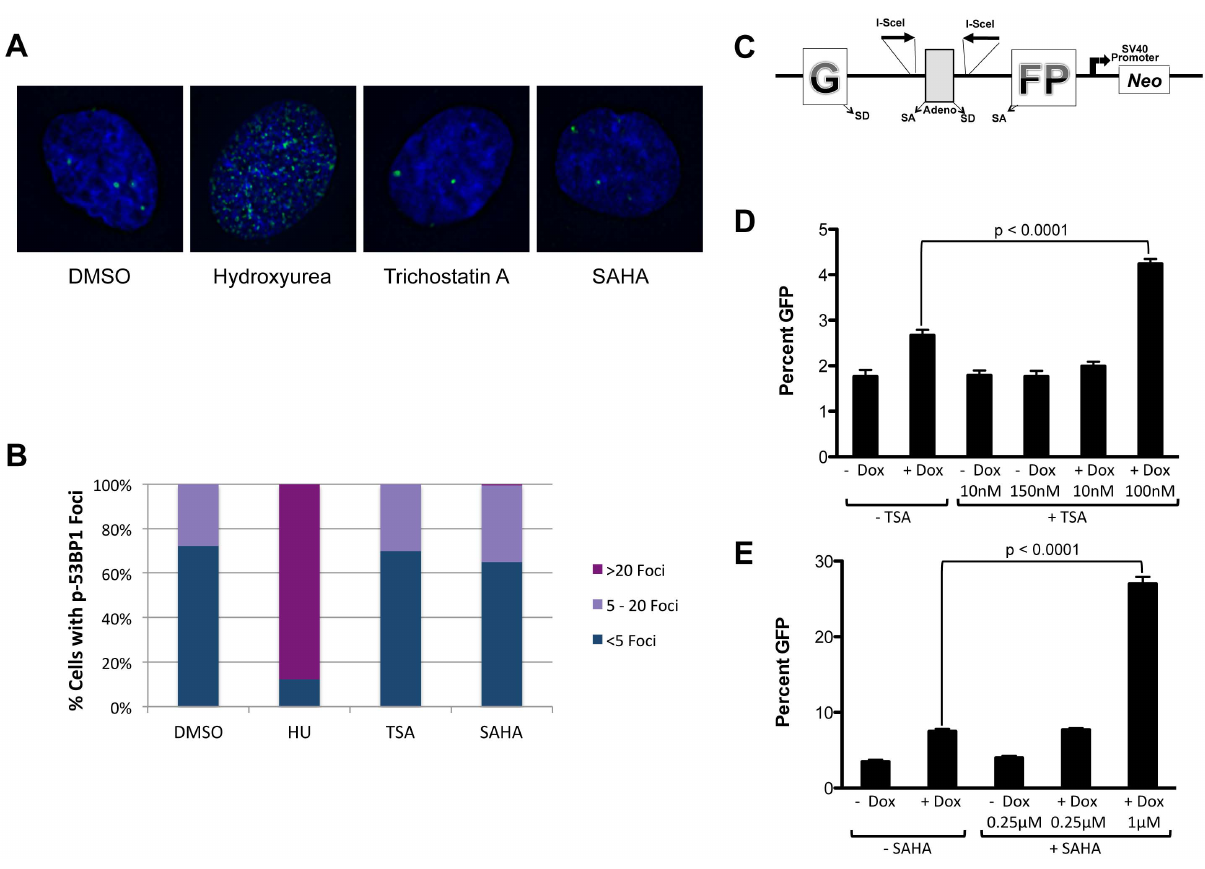
Figure 4. The effect of HDACi on NHEJ. (A) Representative images of RPE nuclei (blue) with p-53BP1 foci (green) after a 24 hr treatment with 2 mM HU or 1 hr treatment with either 0.5 m M TSA or 32 m M SAHA. (B) The percentage of RPE cells containing the indicated number of p-53BP1 foci following treatment as described in A was determined from at least 145 cells per treatment. (C) Schematic of NHEJ assay. HeLa IHN20.22 cells were pulsed for 24 hr with Dox, washed and chased in the presence of the indicated amounts of TSA (D) or SAHA (E) for 3 days. The graphs represent the average percent GFP 6 SD. Significance between + Dox/ 2 TSA or SAHA and + Dox/ + TSA or SAHA was calculated using a two-tailed t-test. The percentage of GFP-positive cells was determined by FACS